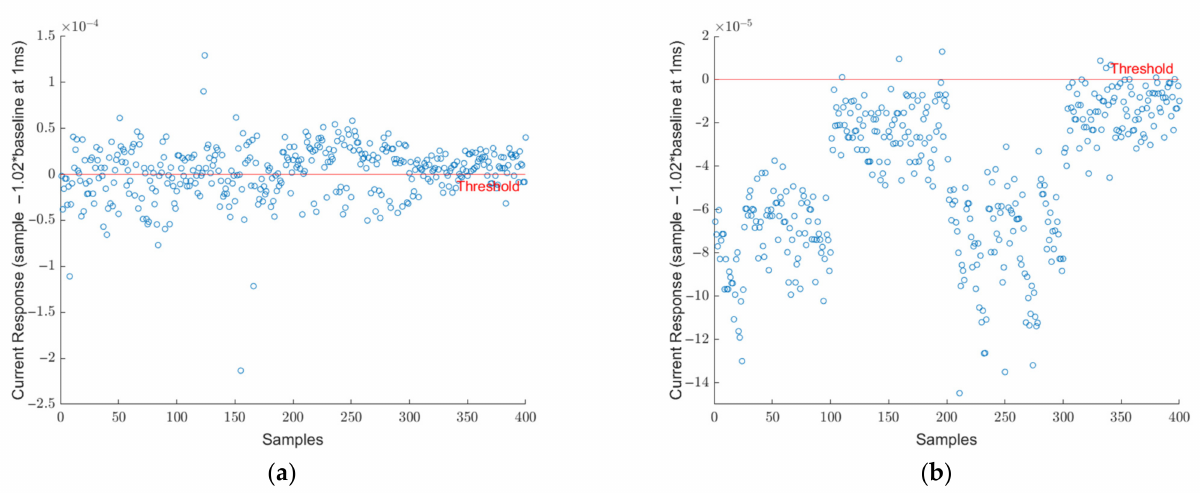
Figure 4. ( a ) Signature analysis of 400 SARS-CoV samples. The 242 out of 400 samples were misclassified as SARS-CoV-2 positive and the rest of the samples falls below the threshold line ( b ) Signature analysis of 400 HCoV-OC43 samples. Most of the samples were correctly classified as SARS-CoV-2 negative. Only 9 samples were classified as SARS-CoV-2